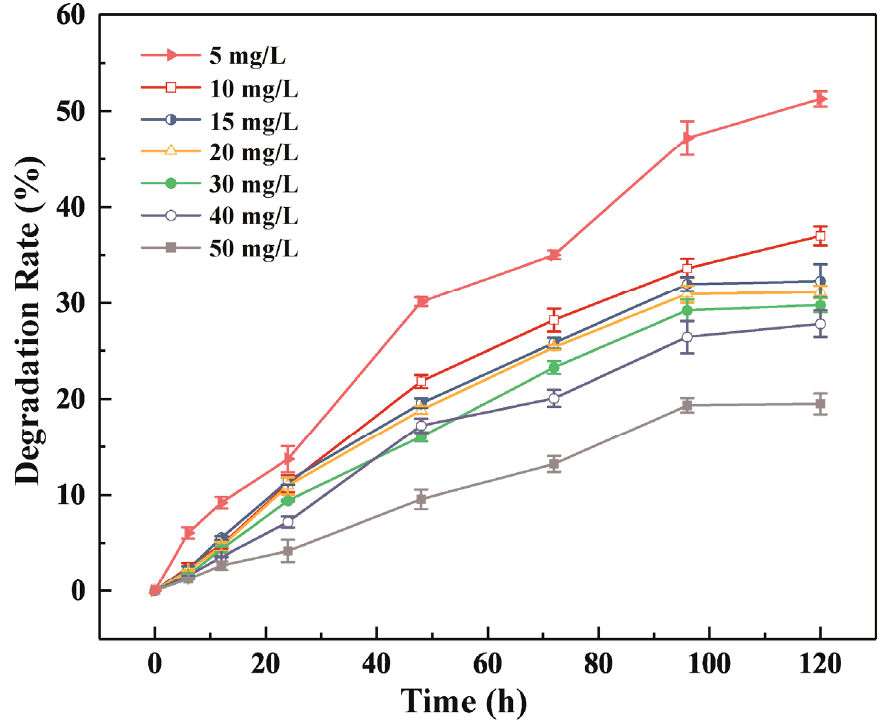
Figure 1. Degradation of BPA by strain R-001 at different concentrations.